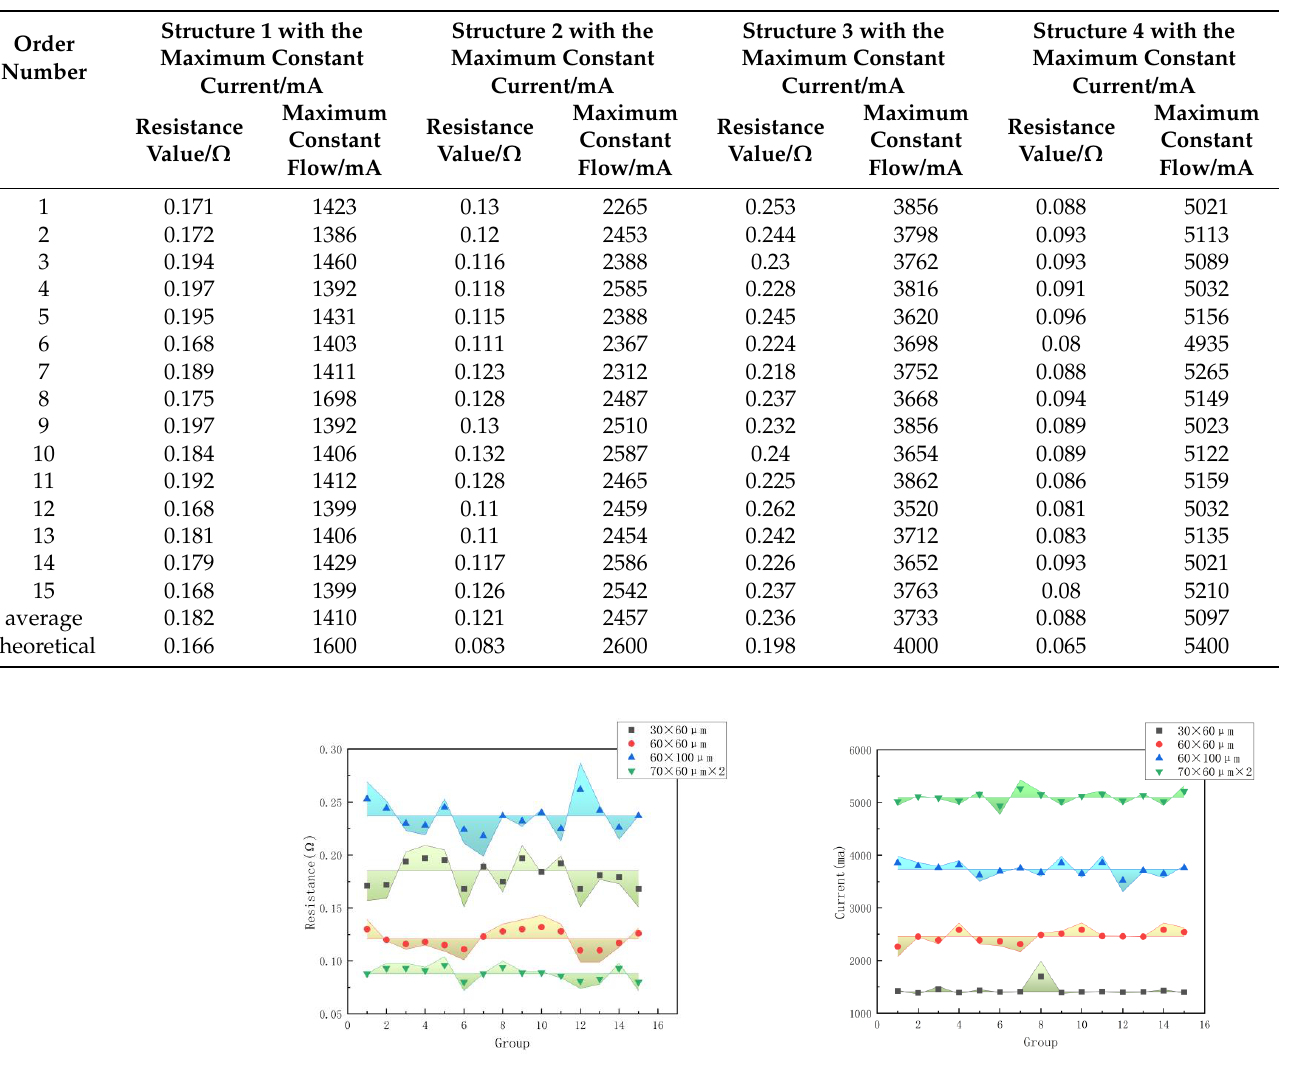
Table 2. Resistance and maximum constant current value of different bridge area sizes.